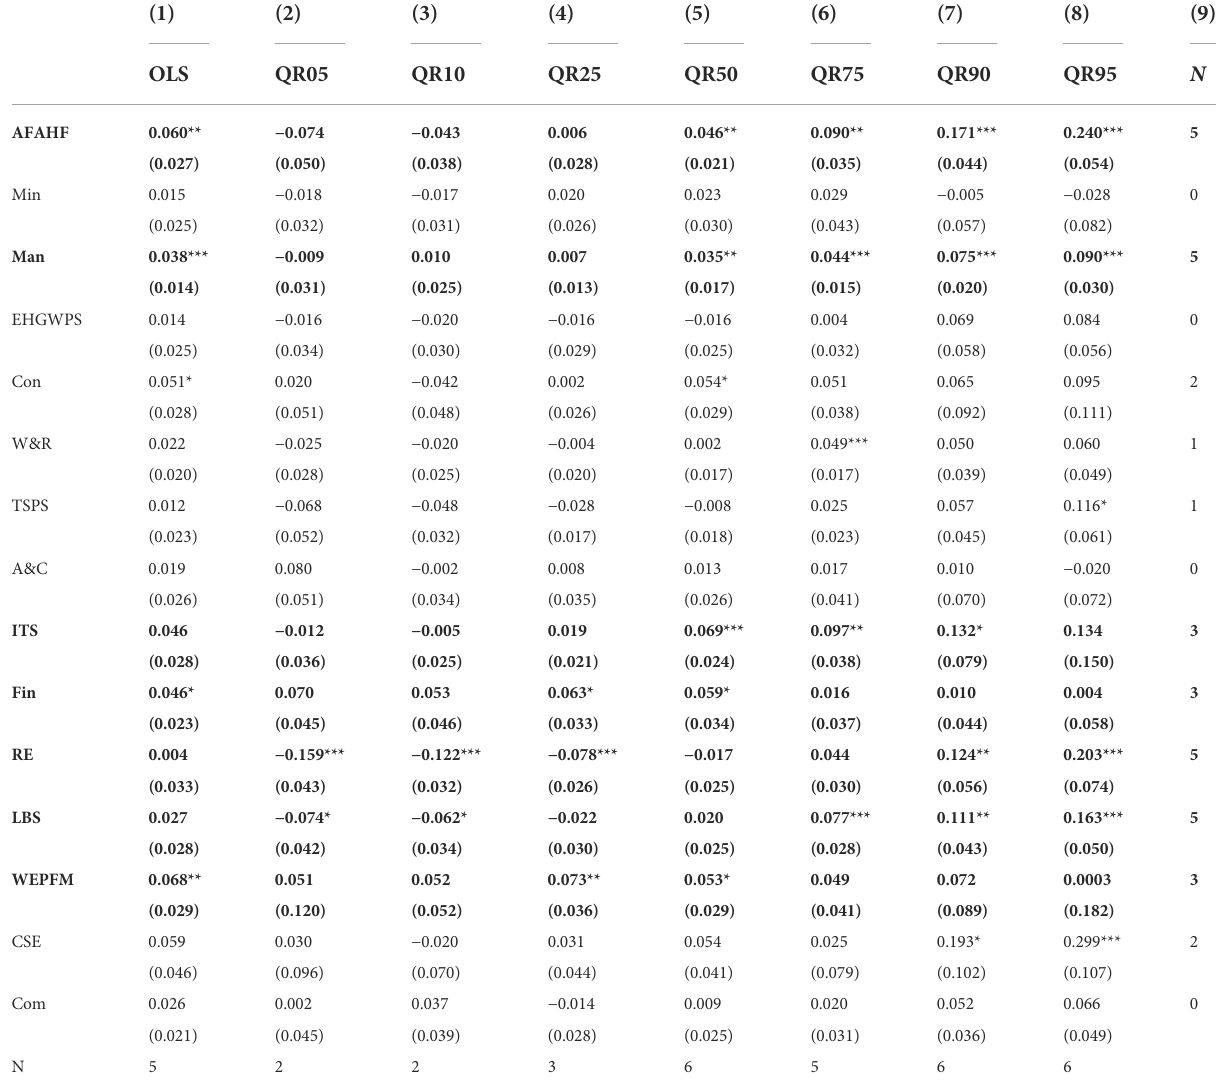
TABLE 10 Robustness check Ⅱ : OLS and quantile regressions based on Trend calculated by Box-Jenkins